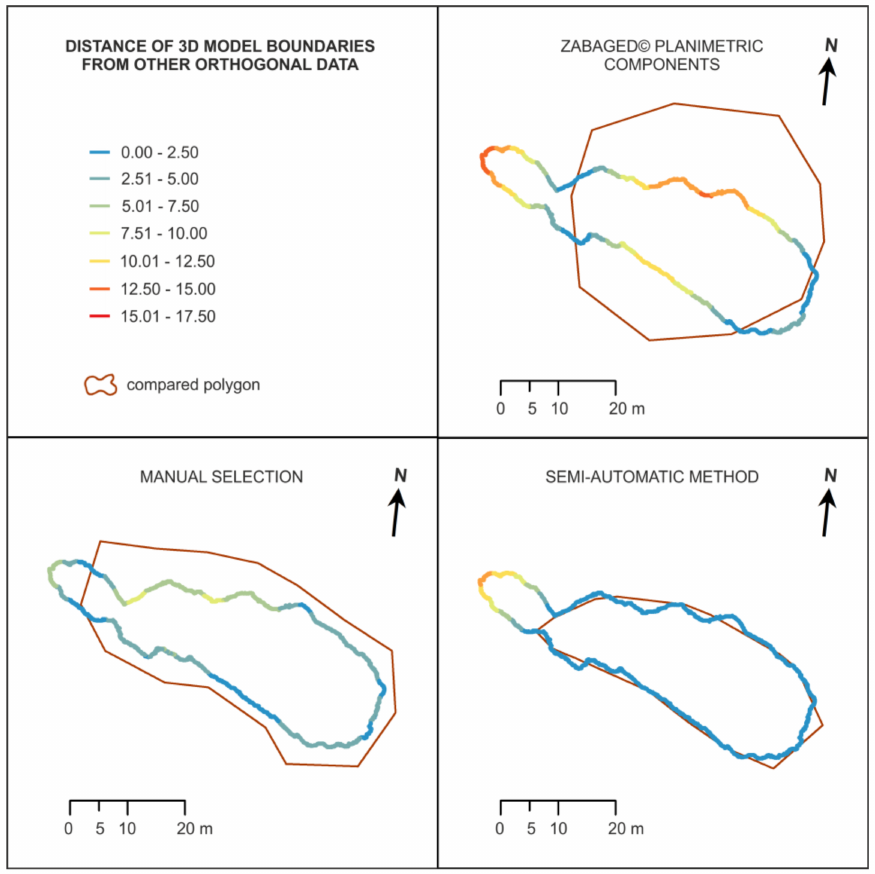
Figure 9. Comparison of 3D rock object layout, ZABAGED ® planimetric components, manual selection, and semi-automatic method (m).